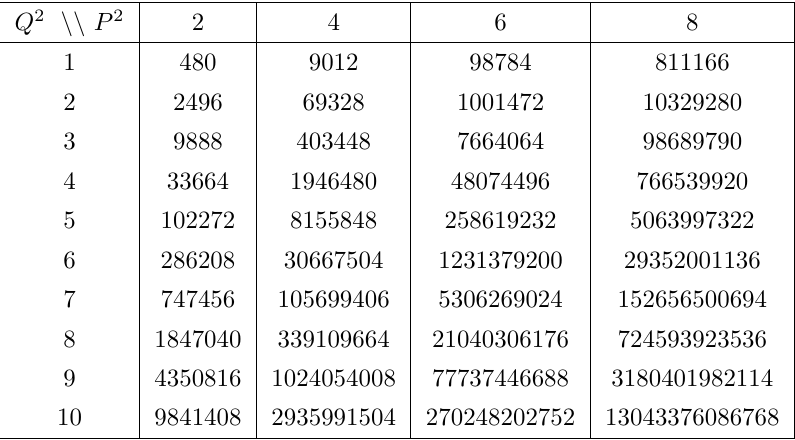
Table 20 . Index of horizon states for the Z 2 orbifold of T 6 for Q · P = 1